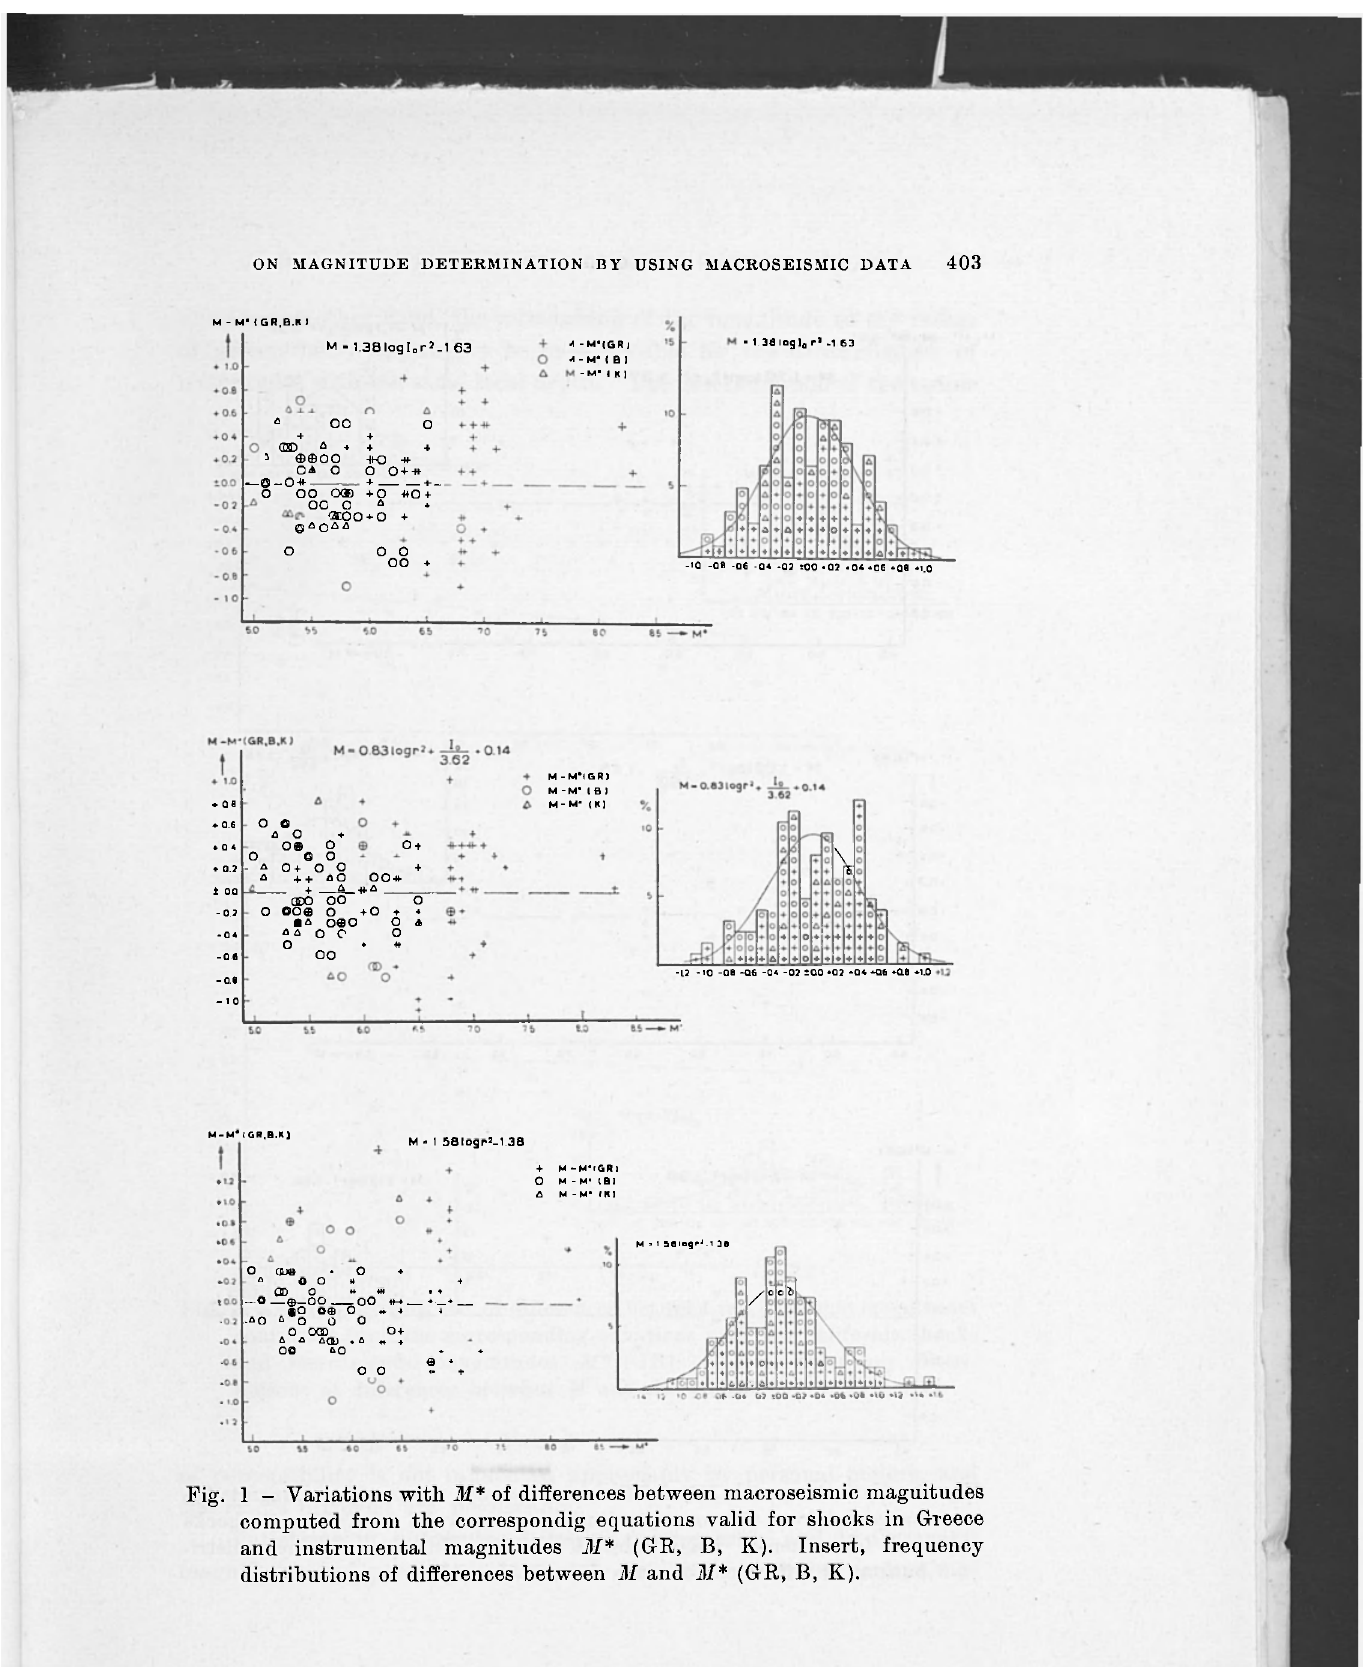
Fig. 1 - Variations witli M* of differences between macroseismic maguitudes computed from the correspondig equations valid for shocks in Greece and instrumentai magnitudes M* (GR, B, K). Insert, frequency distributions of differences between M and 31* (Gli, B,